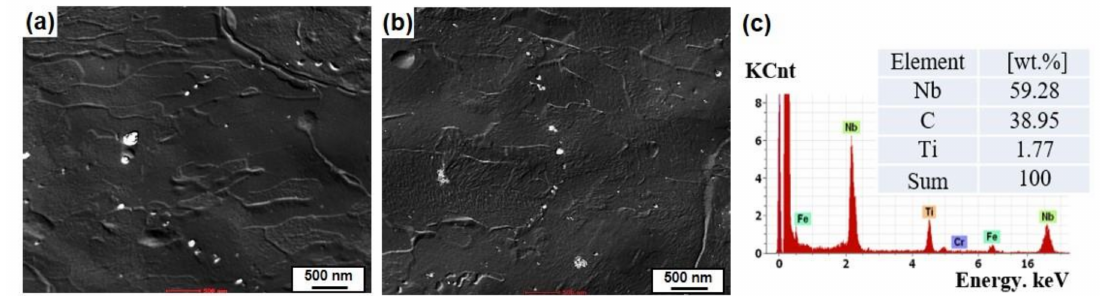
Figure 8. TEM images showing fine-sized precipitates in the steel matrix: ( a ) Steel B and ( b ) Steel C, and ( c ) EDS analysis of fine-sized precipitates.